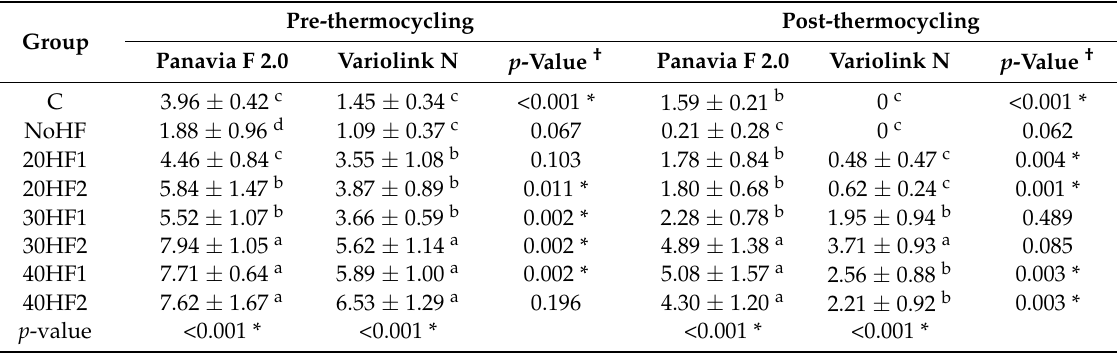
Table 2. Means and standard deviation of shear bond strength for each group (MPa).